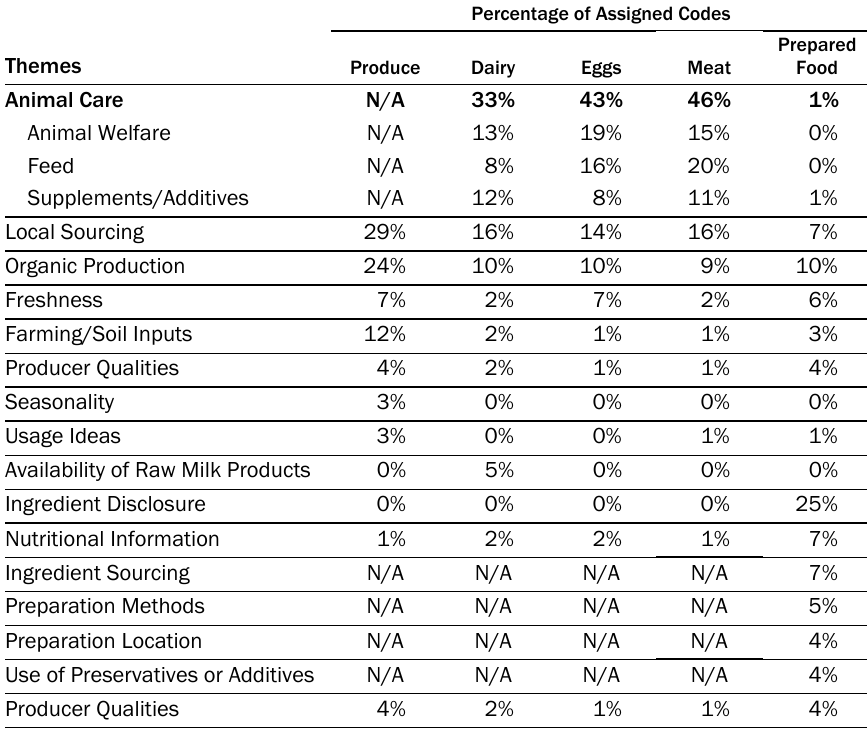
Table 3. Desired Food-Related